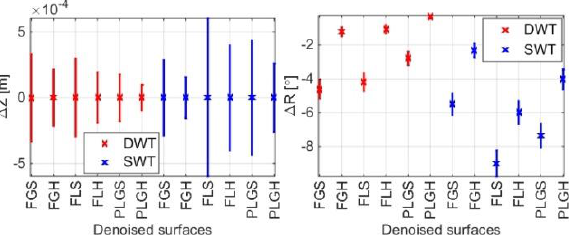
Figure 6. Error plot of ΔZ (left) and ΔR (right) for 12 denoising